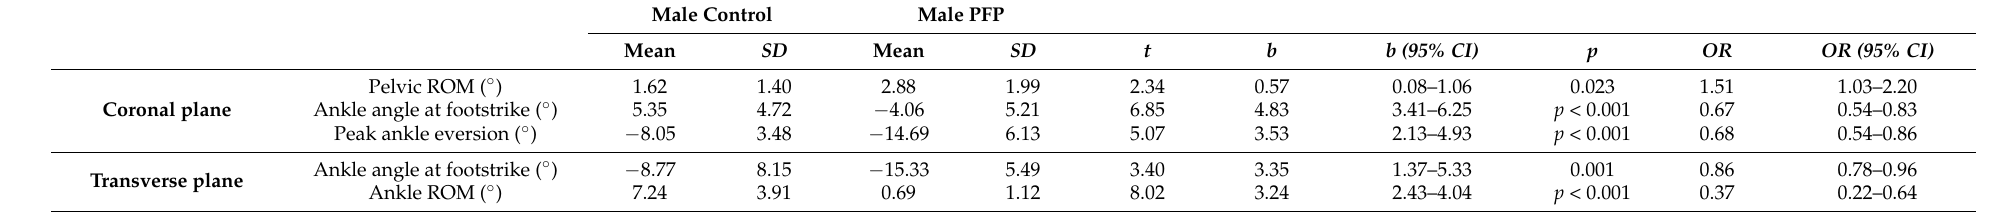
Table 5. Three-dimensional kinematics in male PFP participants and controls.